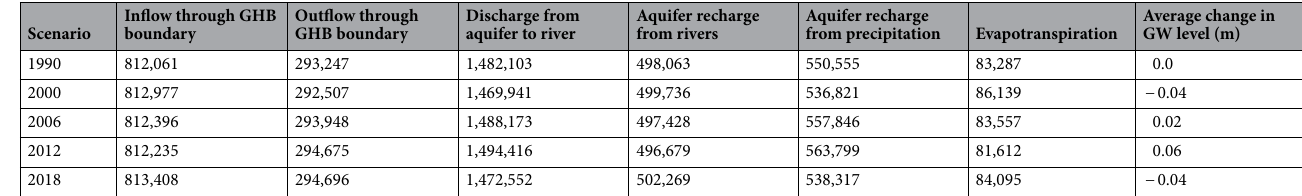
Table 6. Water balance components (in m 3 day −1 ) and changes in average groundwater level with respect to the base case (in